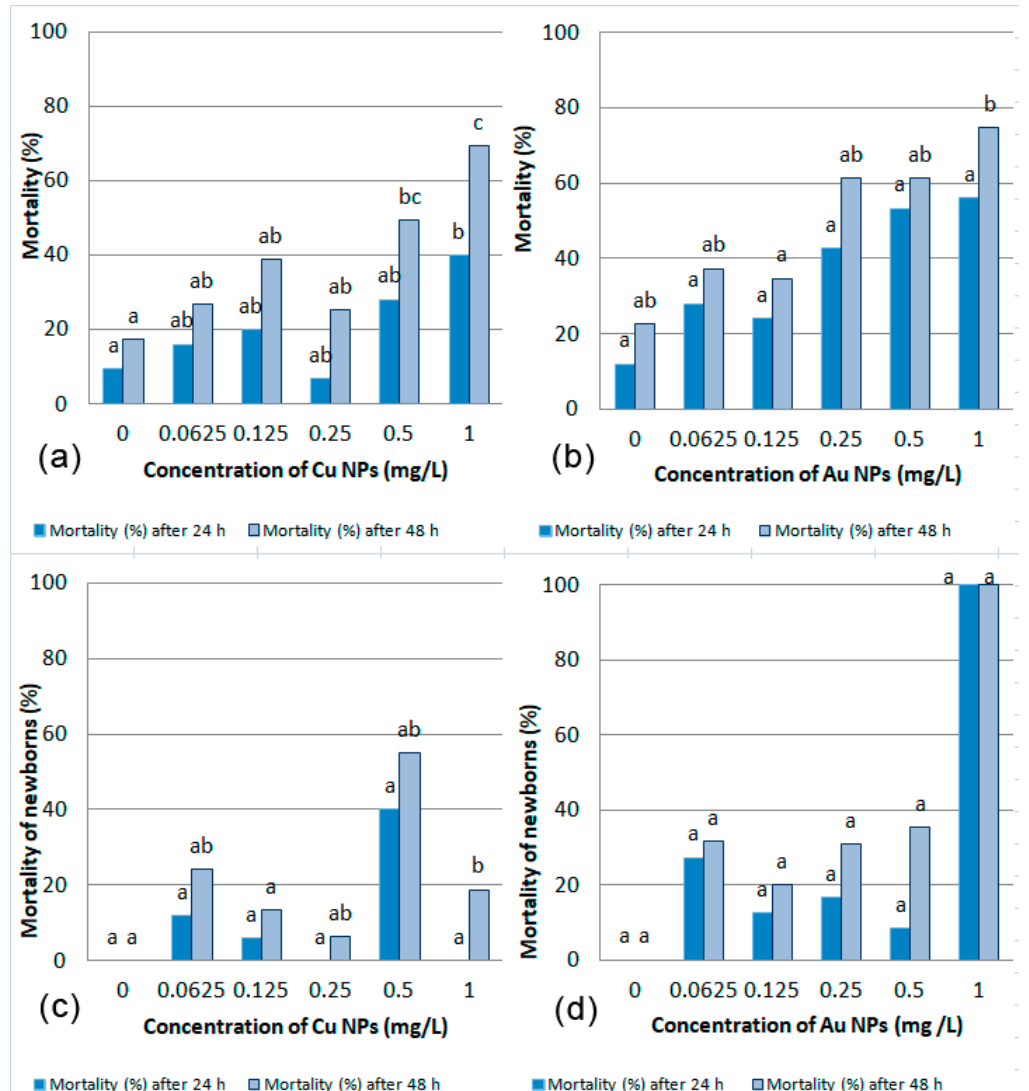
Figure 1. Daphnia pulex mortality (%) of depending on the concentration of Cu NPs (A); Au NPs (B); newborns Daphnia pulex depending on the concentration of Cu NPs (C) and Au NPs (D). Table 2. Effects of different concentrations of NPs solution on survival of newborn Daphnia pulex.